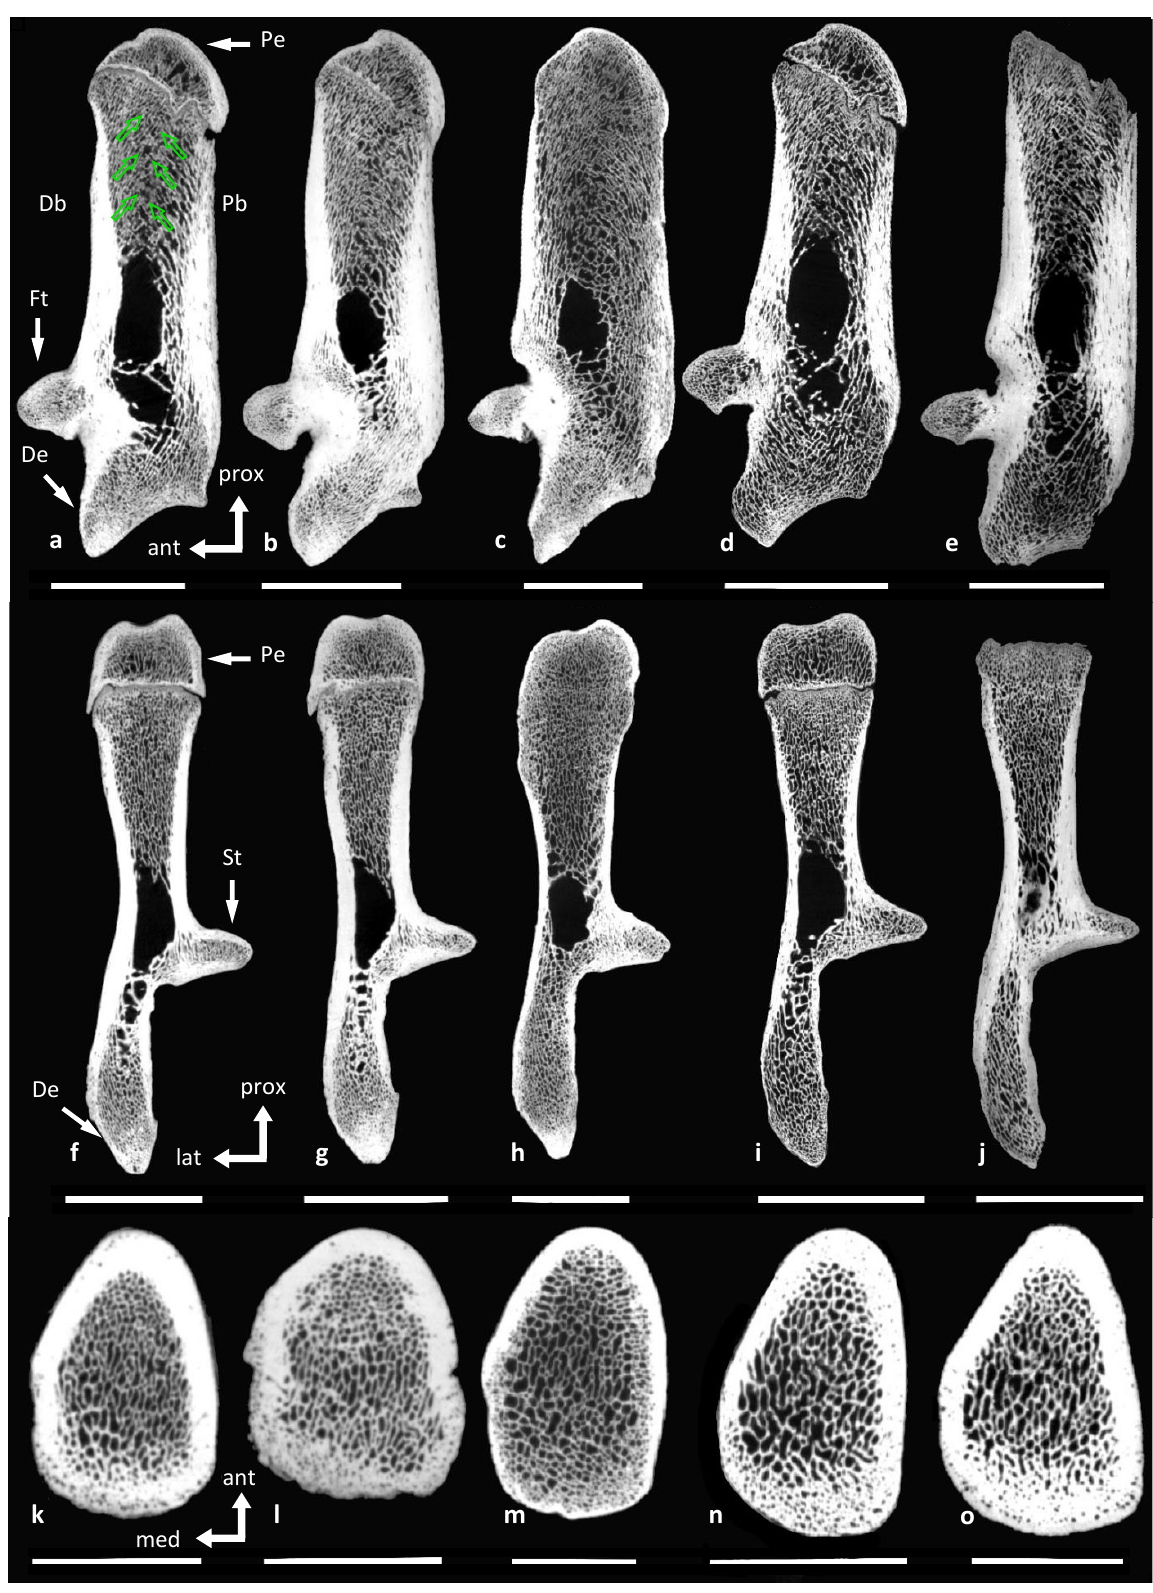
Figure 3: Virtual thin sections of the calcaneus of boars, a,f,k, 2017-555 (Experimental stall); b,g,l 2017-570 (Experimental pen); c,h,m Pradat187 (Experimental control); d,i,n, 2013-1286 (Natural habitat); e,j,o, Calc2139 (Mesolithic). Db, Dorsal border; De, Distal end; Ft, Fibular trochlea; Pb, Plantar border; Pe, Proximal epiphysis; St, Sustentaculu tali . Scale bars of sagittal and frontal sections equal 2 cm; Scale bars of transverse sections equal 1